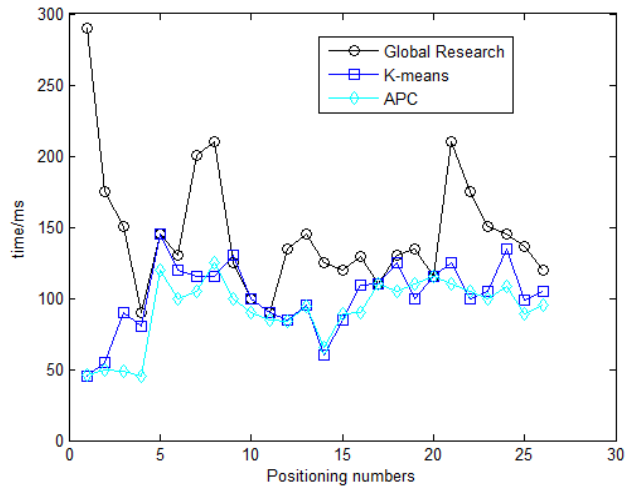
Figure 8. Comparison of static positioning time.